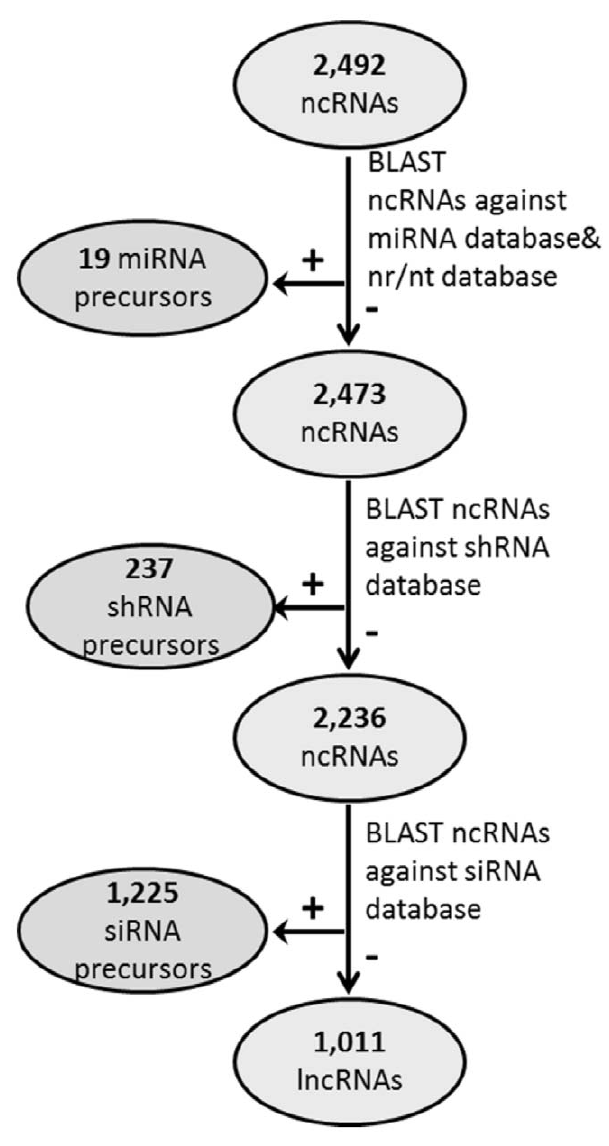
Figure 3. Results for the classification of combined noncoding RNA datasets (ncRNAs) based on small RNA precursor potential. Long noncoding RNA candidates identified above were classified into four different subsets based on alignment with small RNA databases including microRNA sequences (miRNA), short hairpin forming RNA sequences (shRNA),small interfering RNA sequences (siRNA), and those without homology to small RNA sequences, classified as long noncoding RNAs (lncRNA).